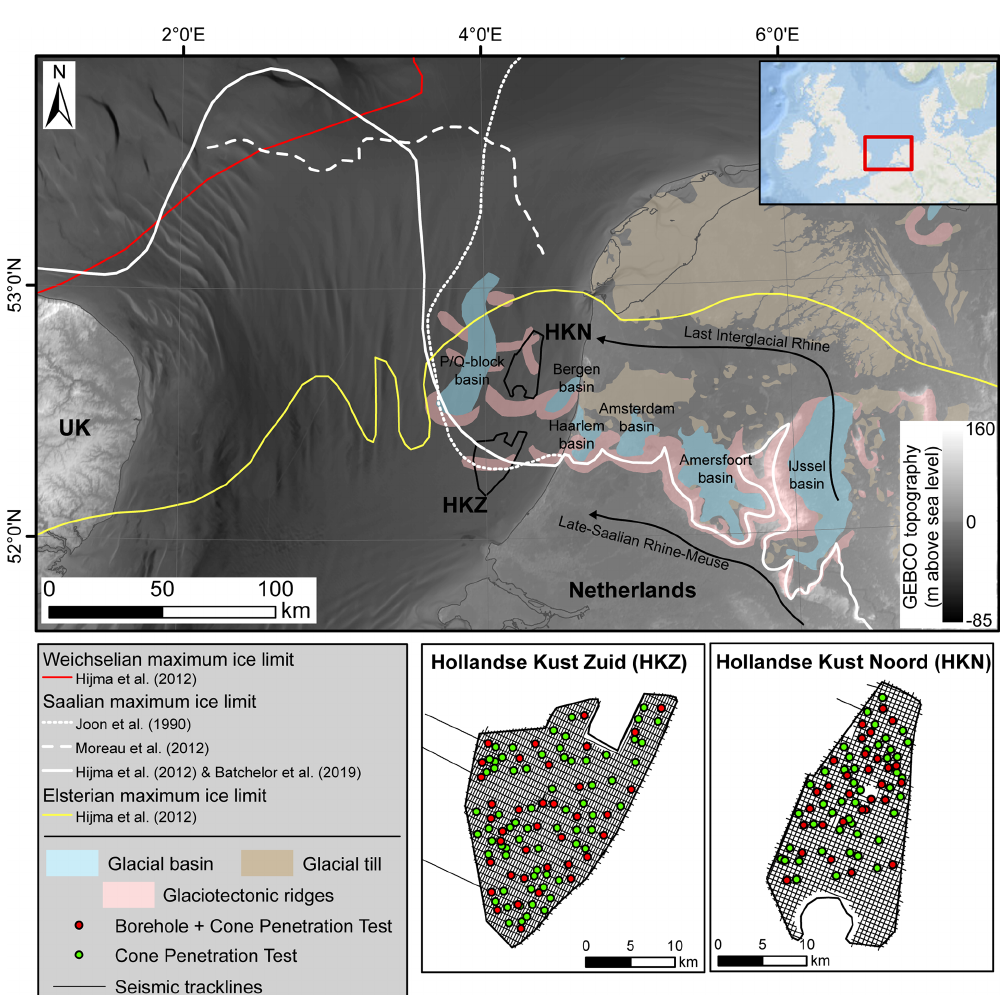
Figure 1. Location of the study area in the southern North Sea showing the Hollandse Kust Noord (HKN) and Zuid (HKZ) wind-farm areas. The offshore maximum ice sheet extension for the Weichselian (Marine Isotope Stage (MIS) 2), late Saalian (MIS 6; Drenthe substage), and Elsterian (MIS 12 and/or 10) glaciations is displayed (modified from Batchelor et al., 2019; Graham et al., 2011; Hijma et al., 2012; Joon et al., 1990; Laban, 1995; Moreau et al., 2012). The seismic track lines displayed correspond to the multi-channel sparker data. Onshore and offshore features are compiled from Laban and van der Meer (2011), Joon et al. (1990), and Peeters et al. (2016). Modern bathymetry and topography are from GEBCO (https://www.gebco.net, last access: 31 October